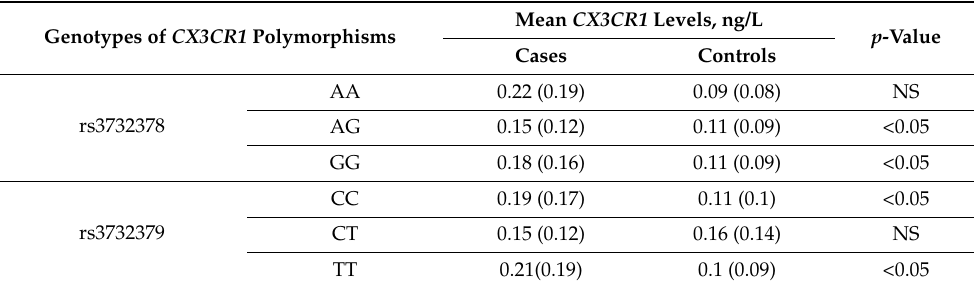
Data are presented as the mean (SD). NS,